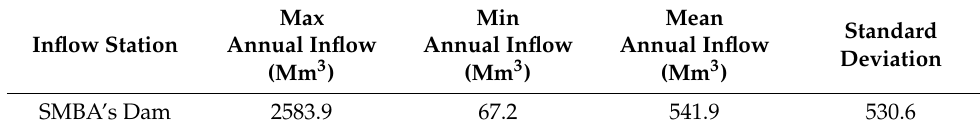
Table 4. Statistical characteristics of the inflow rate dataset of the SMBA dam. Max Inflow Station Annual Inflow SMBA’s